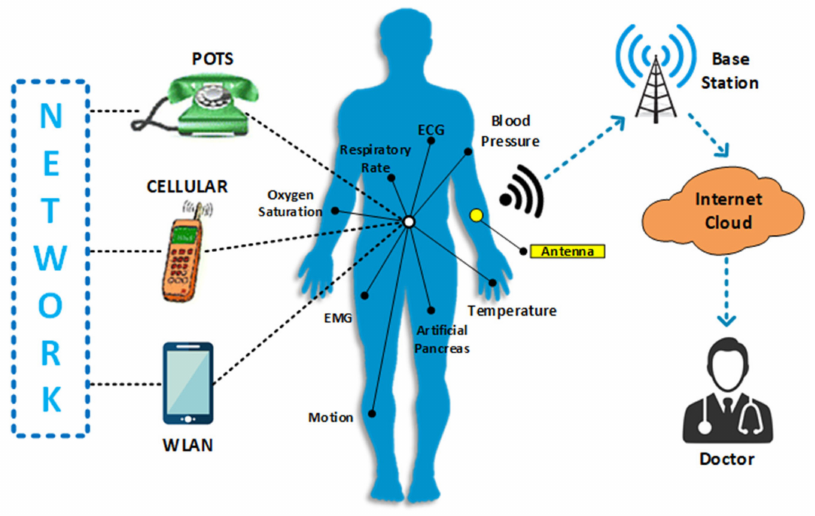
Figure 1. Graphical representation of the in-body medical devices